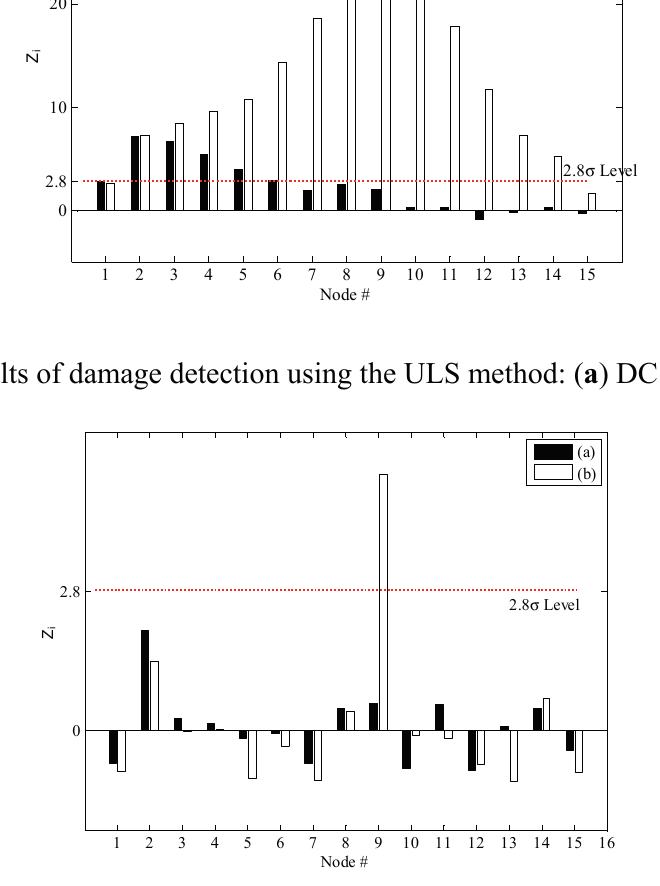
Figure 4. Results of damage detection using the ULS curvature method: ( a ) DC1 and ( b )